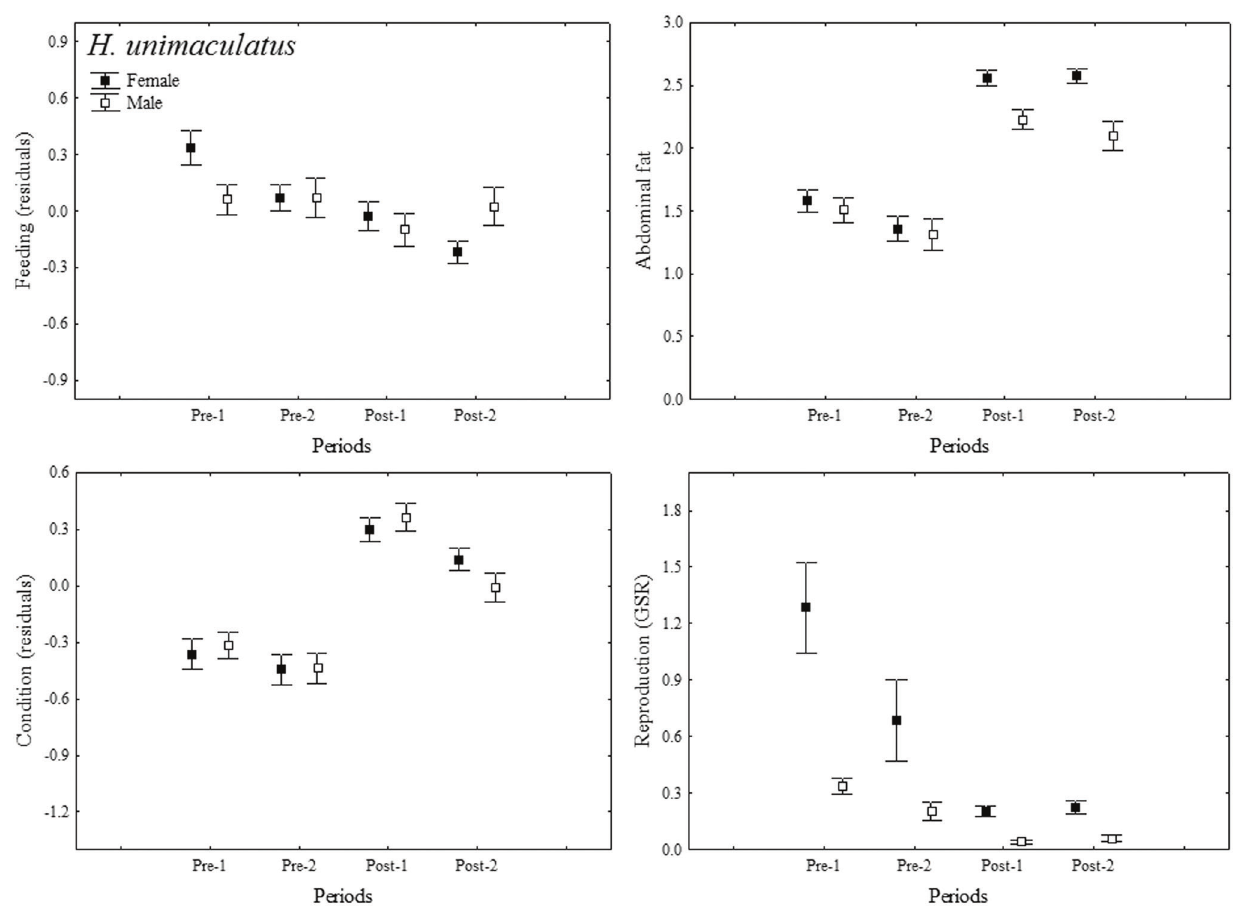
Fig. 4. Variation in feeding activity (standard residuals, regression between LS x WS), visceral fat storage, body condition (standard residuals, regression between LS x TW) and reproductive effort (GSR) of Hemiodus unimaculatus , before (Pre-1 and 2) and after (Post-1 and 2) the construction of Lajeado